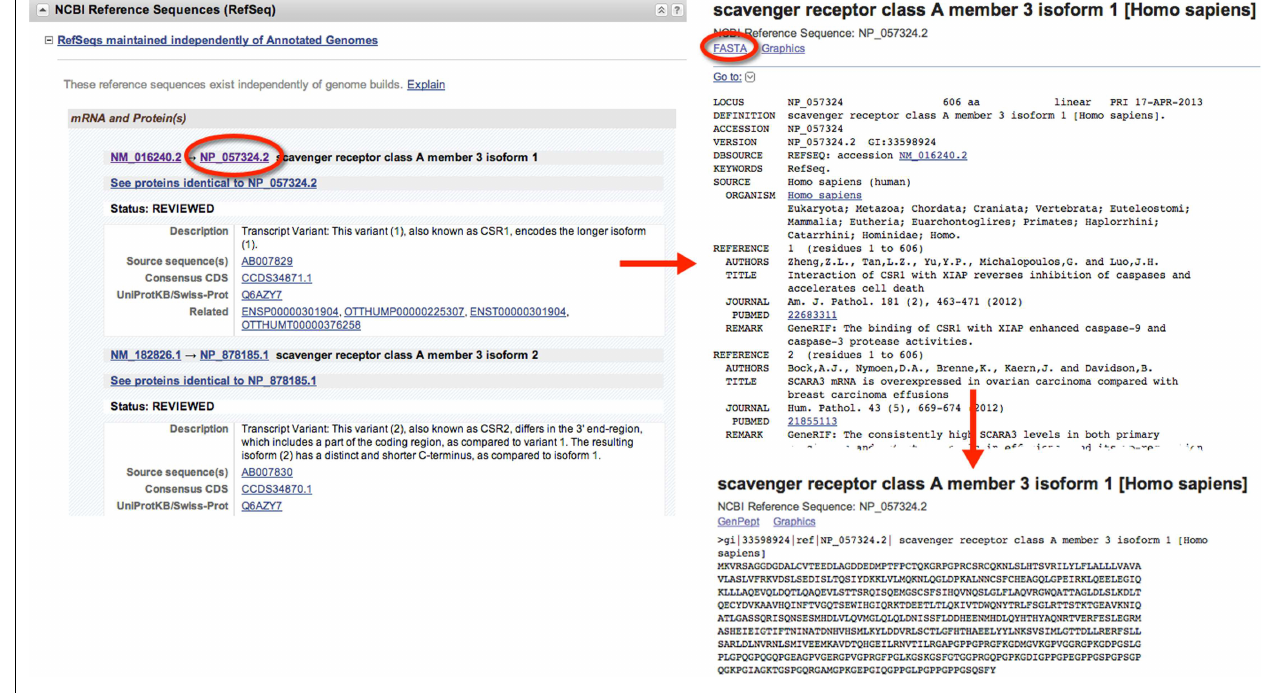
Selecting the NP_057324.2 Accession Identifier, information concerning the SCARA3 isoform 1, protein is displayed, including links to publications involving this protein. By selecting “FASTA” at the top of the page, the FASTA formatted sequence is provided, which includes the reference number, species, and name.This sequence is suitable for input into most online bioinformatic